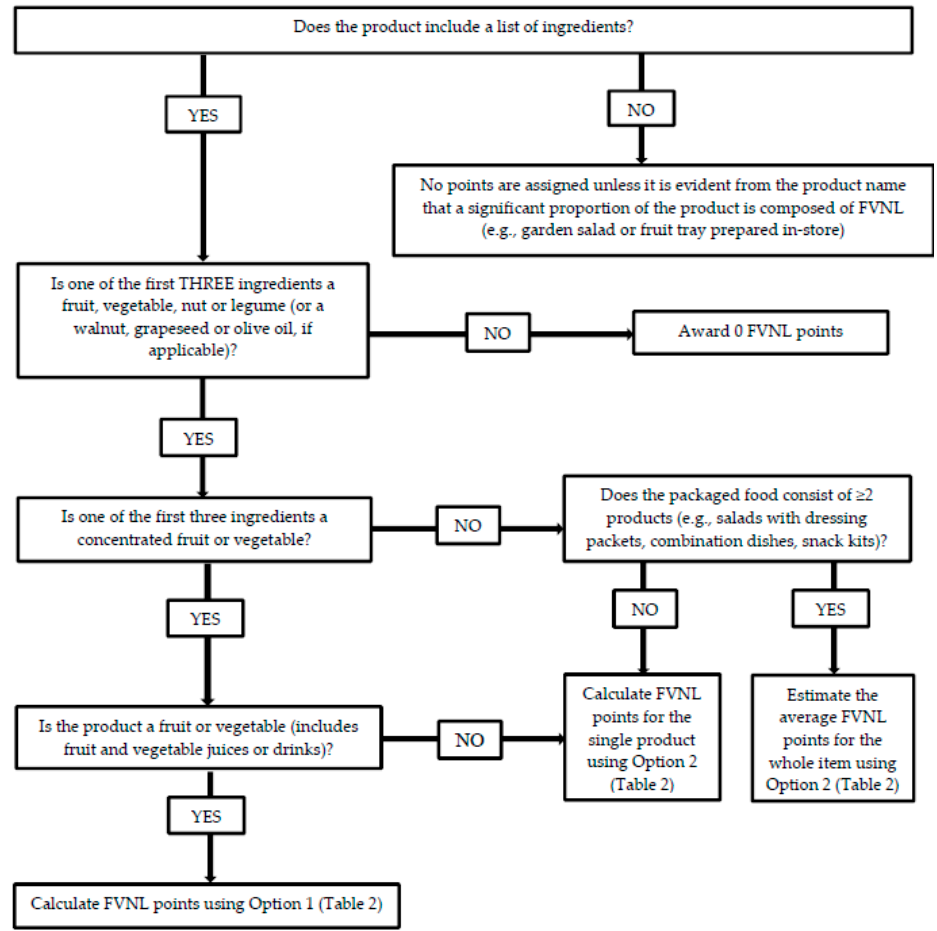
Figure 1. Decision tree for estimating fruit, vegetable, nut and legume (FVNL) points for products without quantitative ingredient declarations for the purposes of applying the Ofcom Nutrient Profile Star Rating system, and the